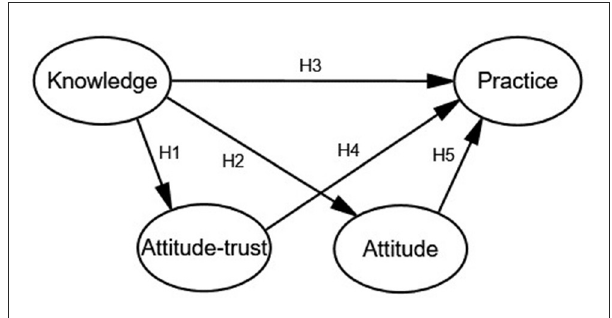
FIGURE1 The KAP constructed equation